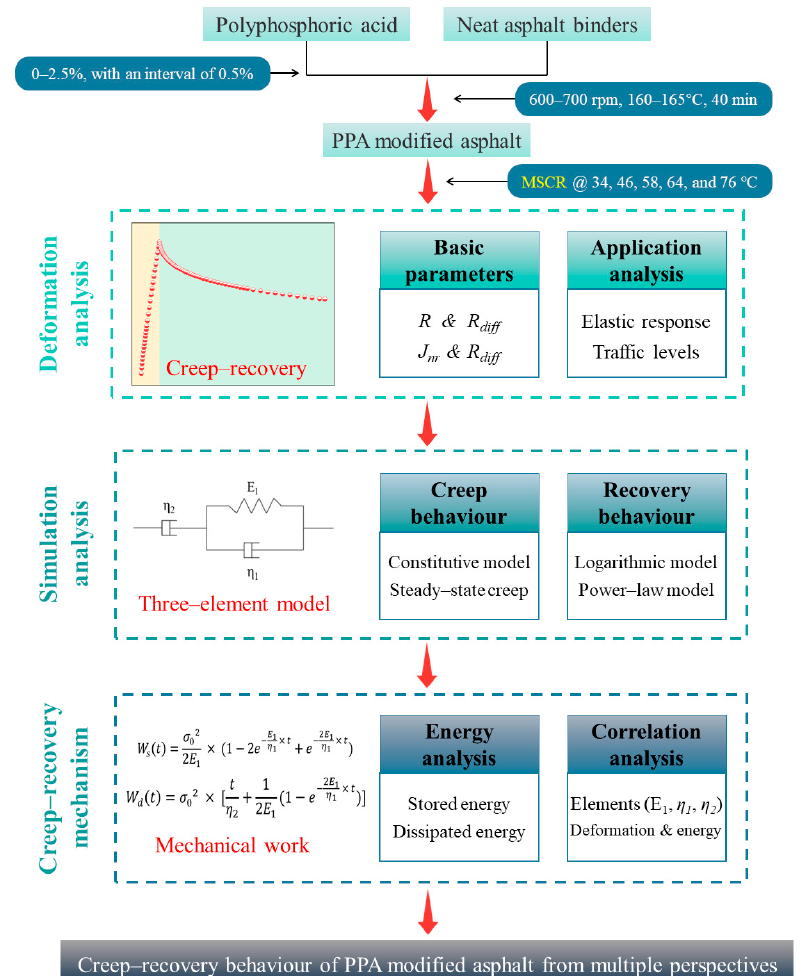
Figure 1. Scheme of the investigation. The creep–recovery curve of asphalt binder is shown in Figure 2.